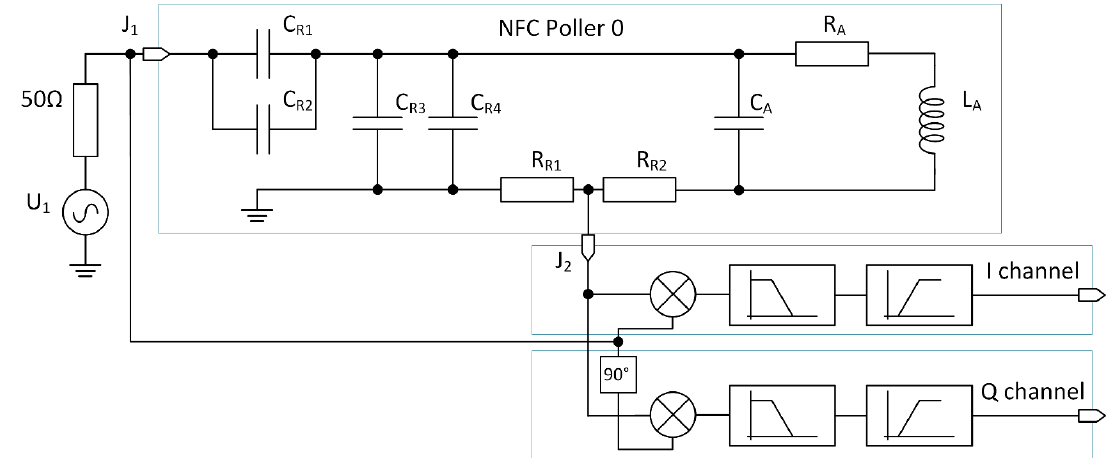
Figure 5. Reader model composed of NFC Poller 0, voltage stimulus, and I and Q channel model.